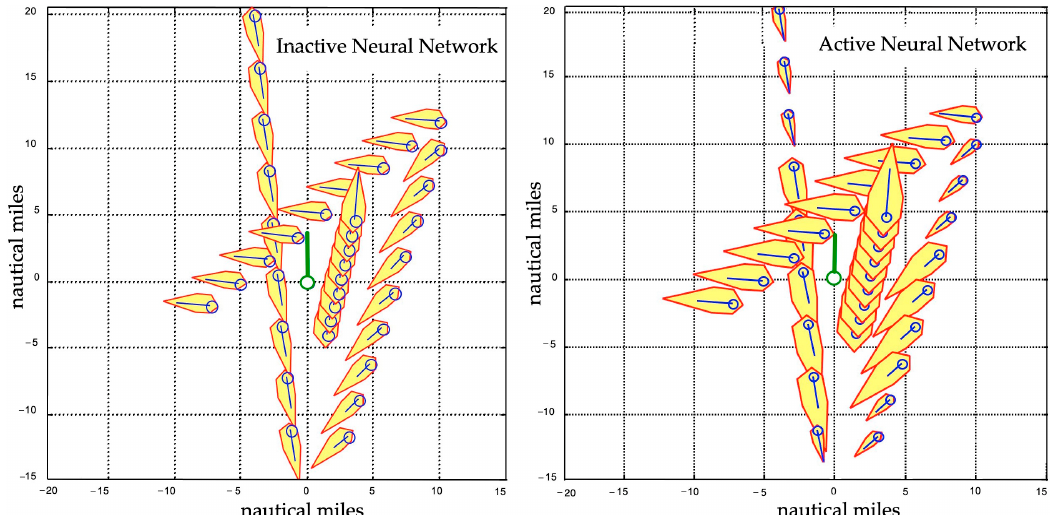
Figure 9. The shape of the neural collision risk domains in the situation of four encountered ships.